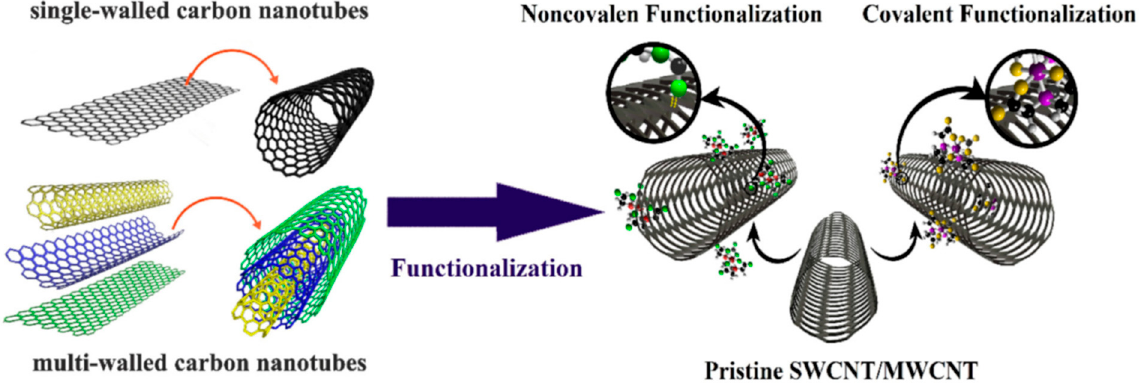
Figure 2. Schematic of the functionalization of SWCNTs and MWCNTs through covalent or noncovalent binding. Reprinted with permission from Life Sciences, Copyright 2020, Elsevier [1].